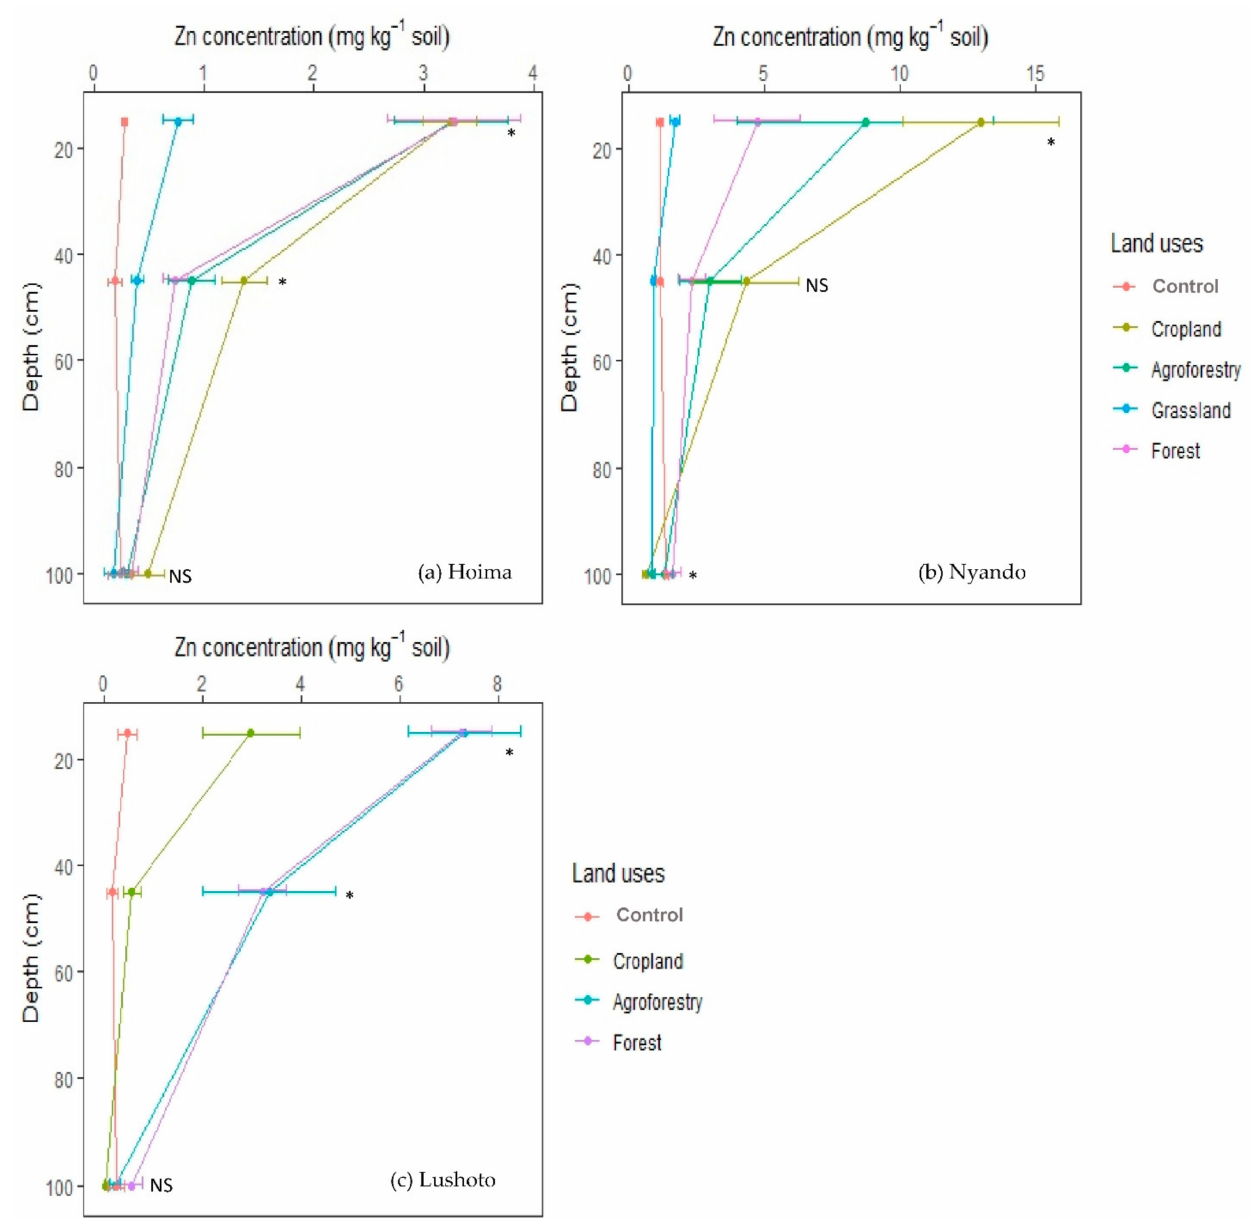
Figure 6. Zinc concentration in ( a ) Hoima, ( b ) Nyando and ( c ) Lushoto at different land uses: cropland, agroforestry, grassland, forest, and control at different soil depths. Error bars represent the standard error of the mean. NS denotes nonsignificant differences; * denotes significant differences at p ≤ 0.05,